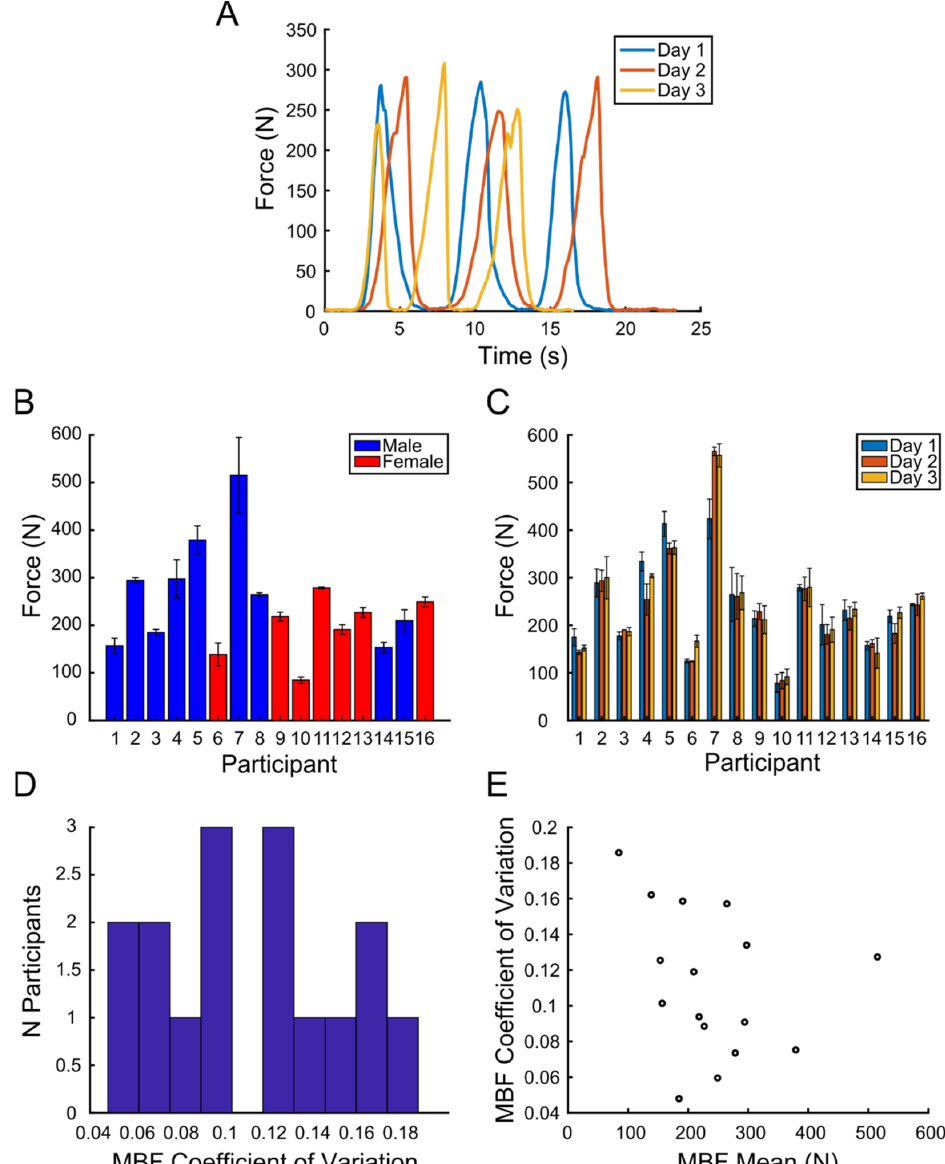
Figure 8. ( A ) Recorded MBF profiles as a function of time for the 3 different sessions (different colors). During each session, subject performed MBF 3 times. ( B ) Mean MBF value over sessions for each subject, (blue) for male and (red) for female. ( C ) Mean MBF value over session repetitions for each subject. ( D ) Histogram of MBF coefficient of variation value, ( E ) MBF coefficient of variation in function of MBF mean.